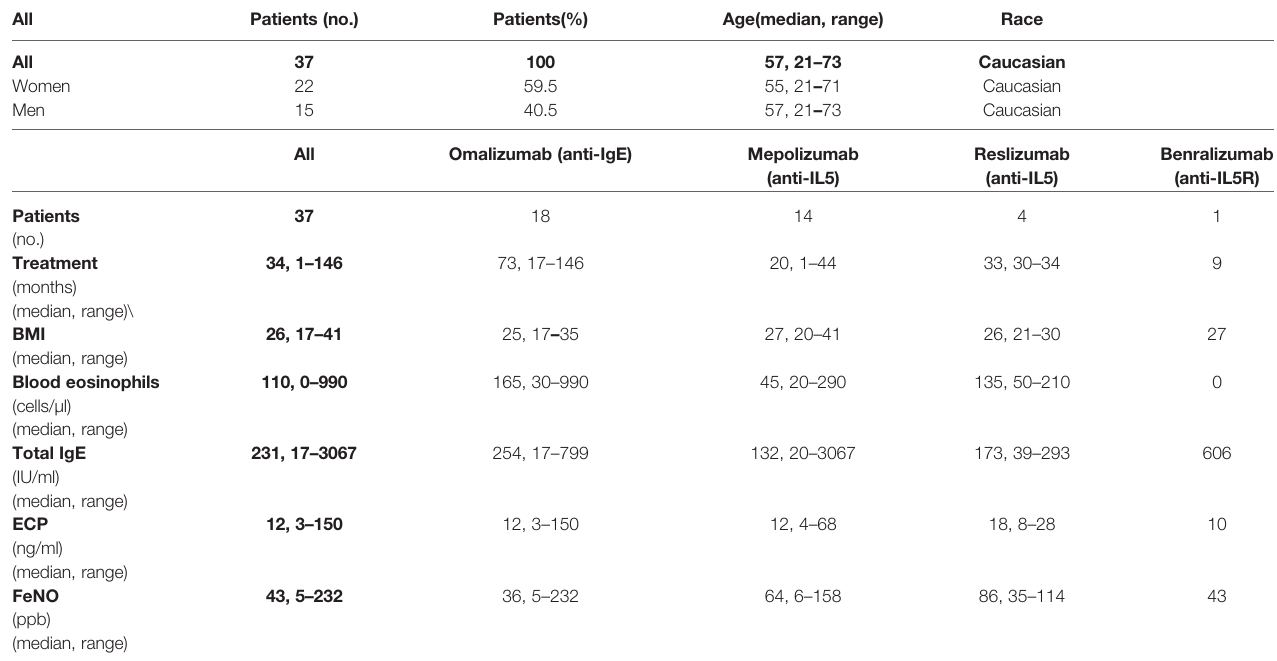
TABLE 1 | The cohort